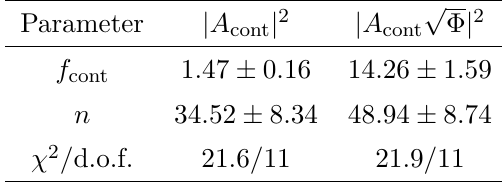
Table 3 . The numerical results for the fit to the cross section of e + e − → φχ c 1 with the pure continuum amplitude (2nd column) and PHSP corrected continuum amplitude (3rd column). The errors are